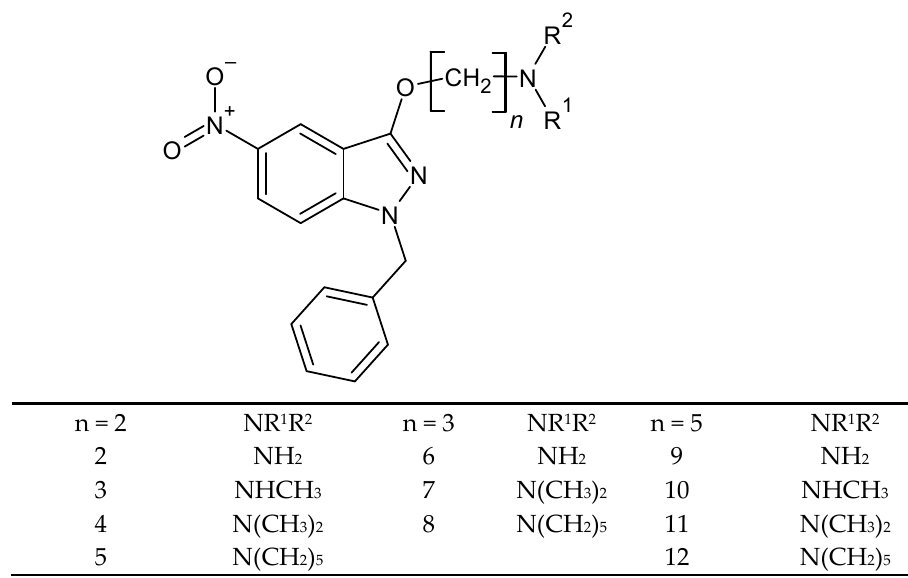
Figure 9. The structure of 3- (ω -aminoalkoxy)-1-benzyl-5-nitroindazoles. In 2020, Alves et al. published the results of in vitro and in silico activity studies of 12 derivatives of furan-2-yl-N-acylhydrazone (PFUR) against Trichomonas vaginalis (Fig- ure 10) [60]. Due to the increasing resistance to metronidazole, there is a need to search for new compounds effective against the above parasite. Furanyl-N-acylhydrazone deriv- atives have high biological activity: antimalarial, antitumor, antifungal and antibacterial, antiviral, anti-inflammatory, antifungal, and anticancer properties [65]. The combination of both pharmacophore groups in PFUR compounds grants a chance to ob- tain new compounds with promising biological activity.